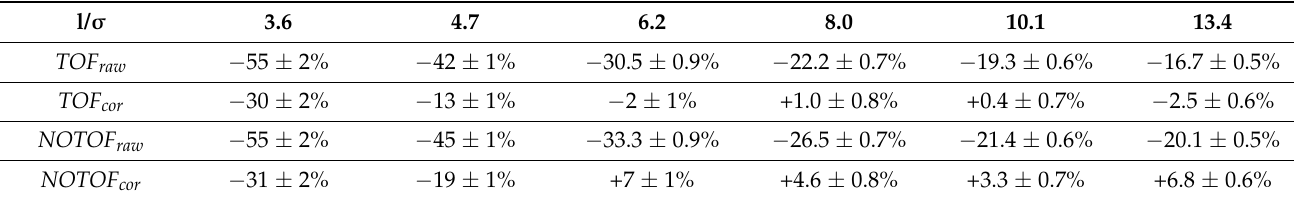
Table 6. Comparison of percentage of recovery for the same acquisition time (4 min) between the reconstruction with TOF correction and the one without TOF.